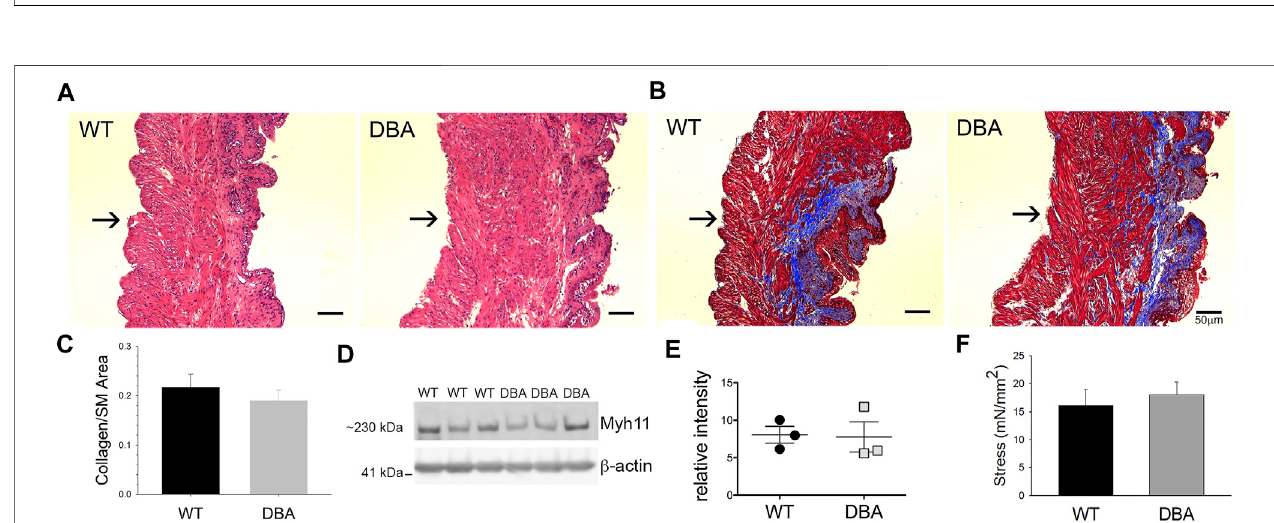
FIGURE 7 | Morphologic, functional and molecular evaluation of bladder smooth muscle contractile apparatus. Histomorphometric evaluation of bladder tissue sections stained with H&E (A) and MT (B) from WT ( N = 3) and DBA ( N = 3) mice (Mag X10, scale bar 50 µm, arrows indicate serosa). (C) Quanti fi cation of the collagen/ smoothmuscle (SM) ratiowascomparable between WT (black bar) and DBA (graybar) bladders. (D) Representative Western blot and (E) quantitative graphofintensity of myosin heavy chain (Myh11) immunoreactivity detected in protein lysates from mucosa-denuded WT and DBA bladders. Band intensities in WT (black circles, N =3)werenotdifferentfromDBA(graysquares, N =3)whennormalized byß-actin,whichwasusedastheloadingcontrol. (F) Contractileresponsesinducedbydirect smooth muscle depolarization achieved by KCl 120 mM in WT ( N = 11, black bar) and DBA ( N = 13, gray bar) bladders were not different.